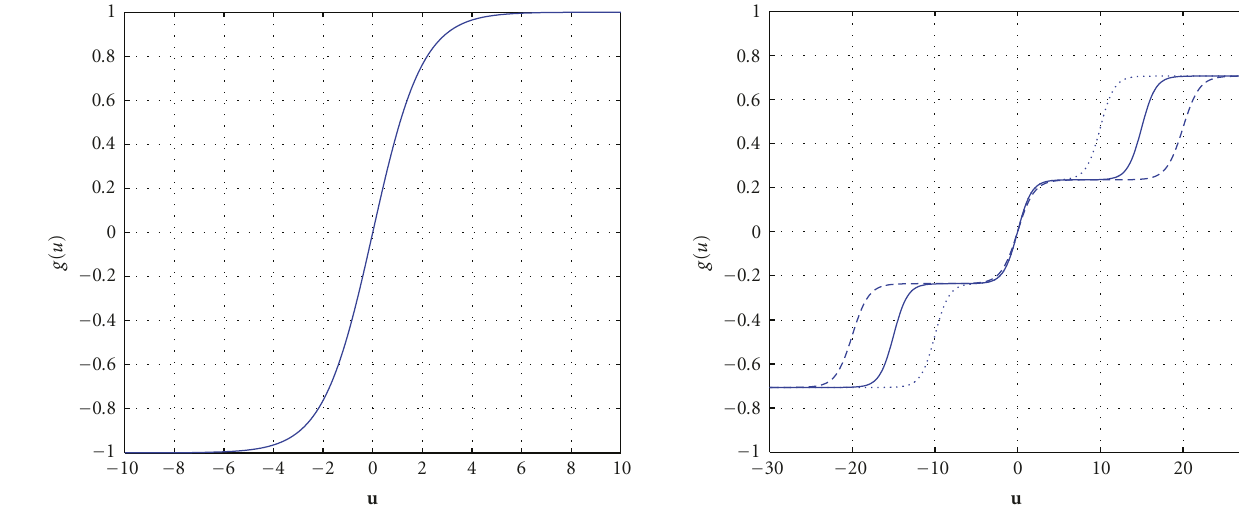
Figure 3: The bipolar decision function.